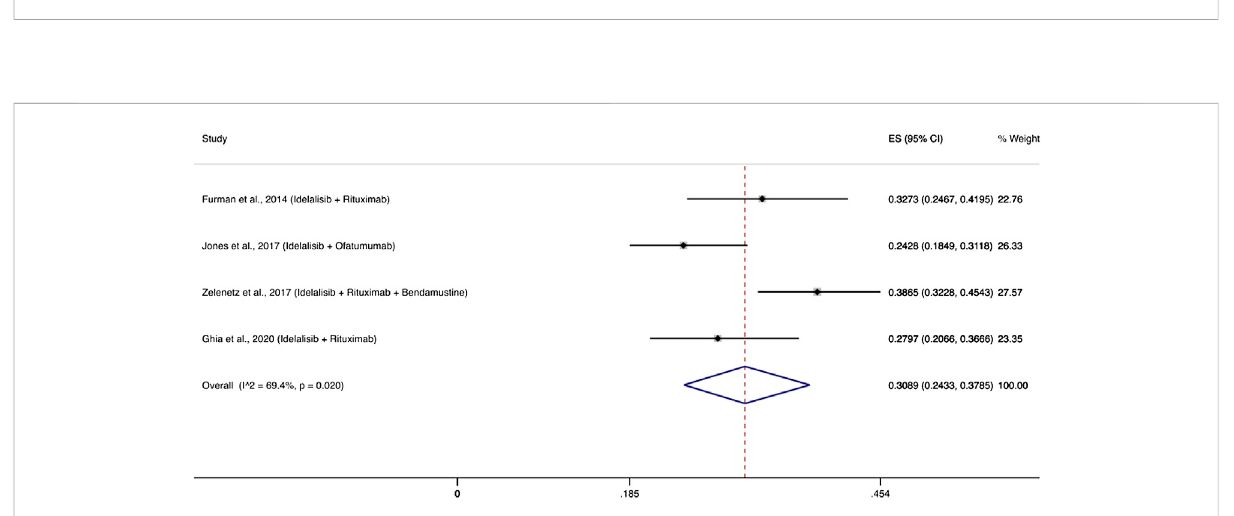
FIGURE 4 Cumulativeincidence rate of severe infections for PI3K δ inhibitors. Individual and combined estimates of the incidence of severe infections for patients treated with PI3K inhibitors with 95% con fi dence intervals. ES: Effect Size (Cumulative incidence).